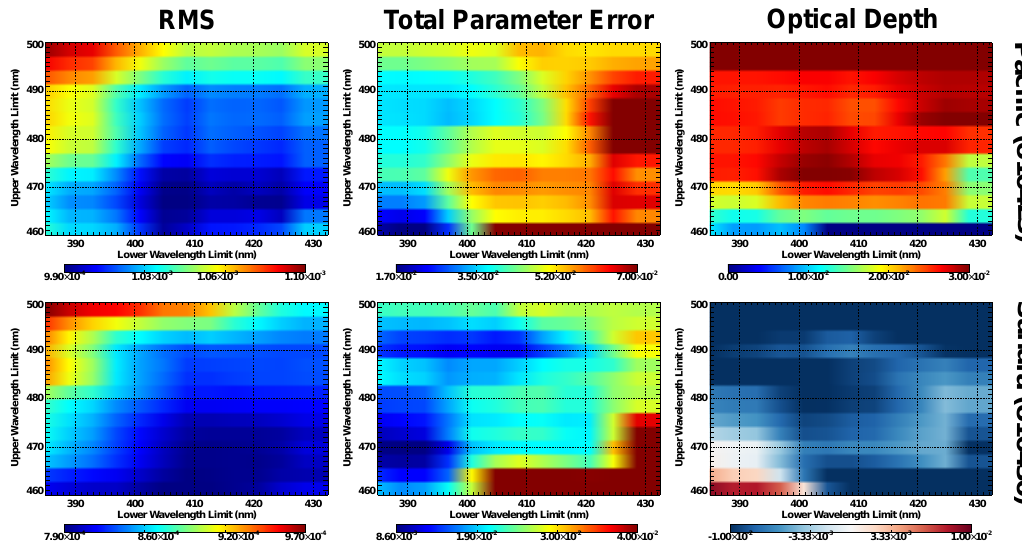
Figure 9. Retrieval window interval maps for spectra over the remote Pacific Ocean (top) and Sahara (bottom). The rms spectrum fit residuals are adjusted for statistical degrees of freedom; cf. Eq. (19). Liquid water optical depths and associated parameter errors are those at 460nm.